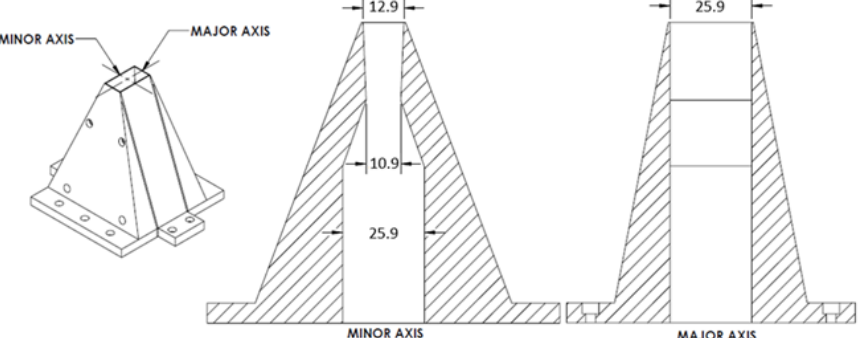
Figure 2 . Baseline nozzle geometry adapted from reference [9], dimensions in mm. Figure 2. Baseline nozzle geometry adapted from reference [9], dimensions in mm.